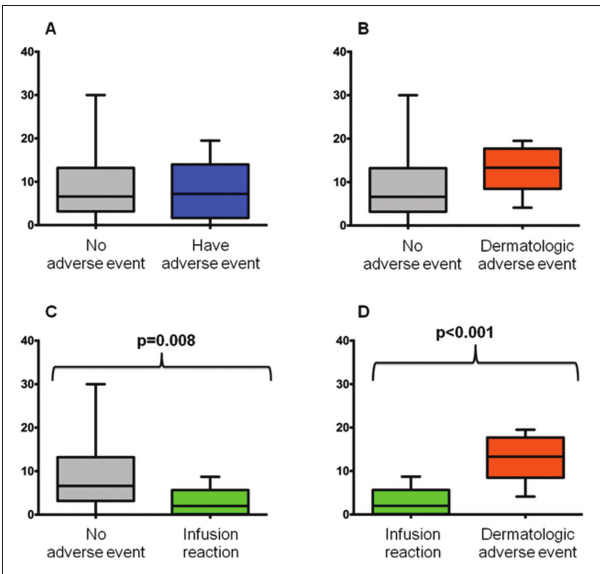
Figure 2) Infliximab trough level was correlated with type of infliximab- associated adverse event. No adverse event (n=53), experience adverse event (n=18) ( A ); dermatological adverse event (n=9) ( B ); infusion reaction (n=9) ( C ); infusion reactions versus dermatological adverse events ( D ). Median, 25th percentile to 75th percentile, minimum and maximum values for infliximab trough levels (μg/mL) are